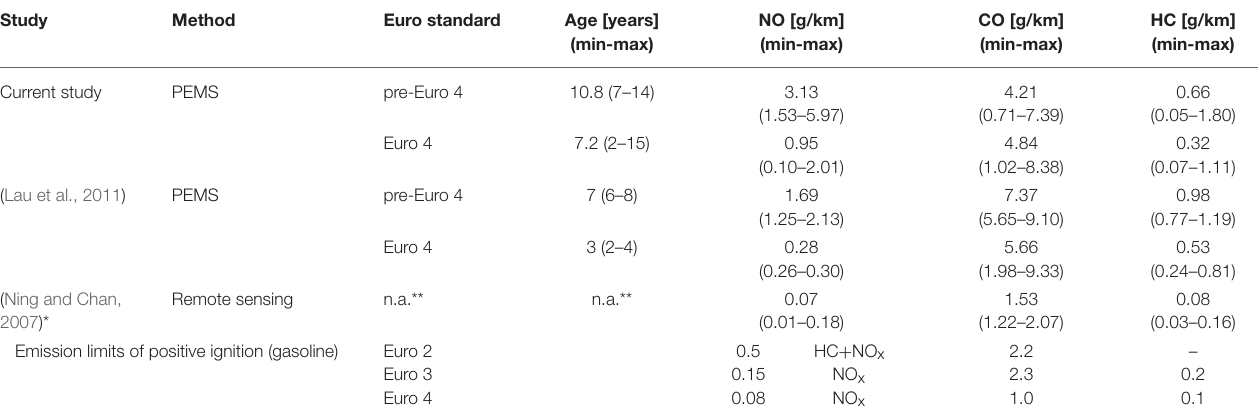
TABLE 4 | Emission levels comparison to previous